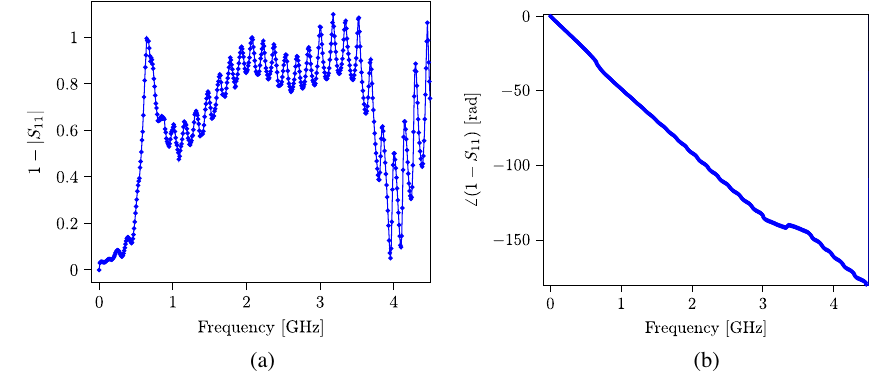
FIG. 21. (a) Magnitude response and (b) Phase response calculated from S11